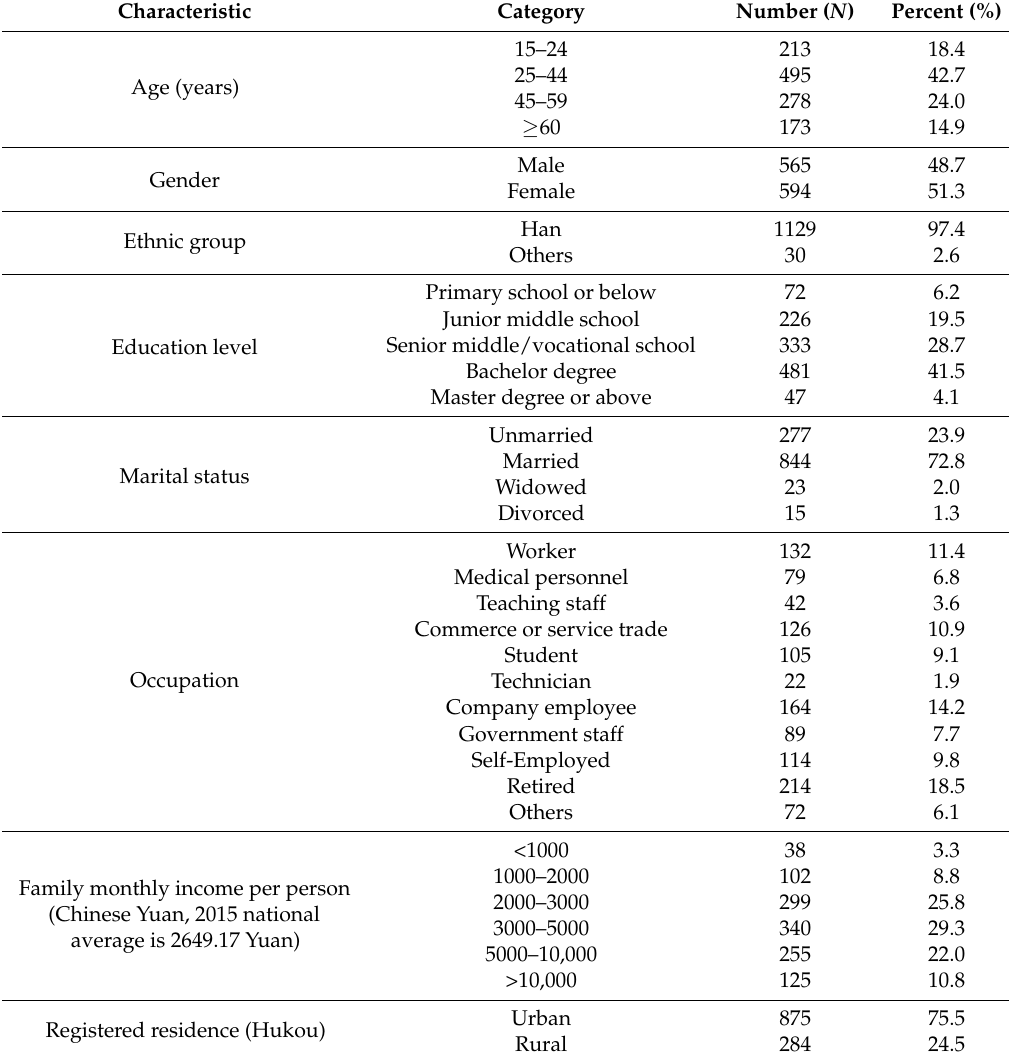
Table 2. Demographic characteristics of the study participants ( N =